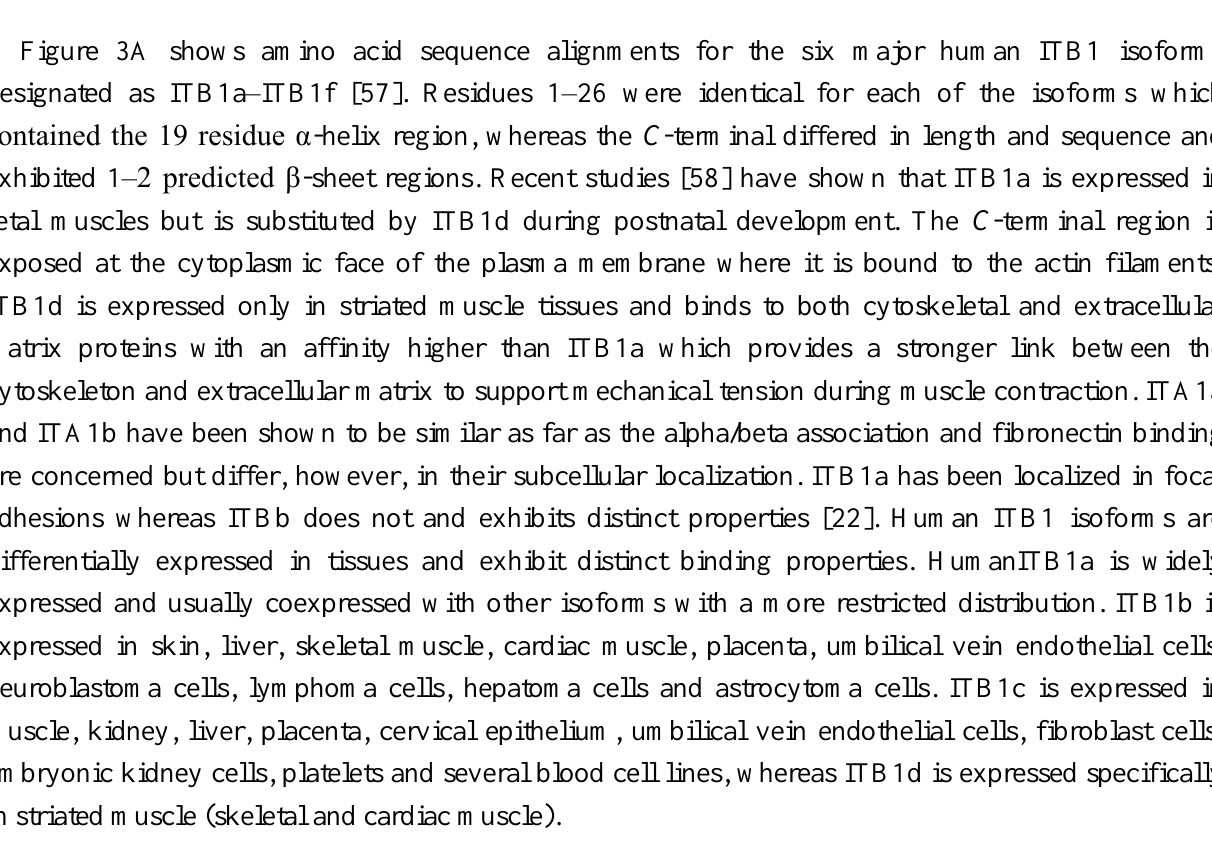
Figure 3. Amino acid sequence alignments for vertebrate ITB cytosolic domain